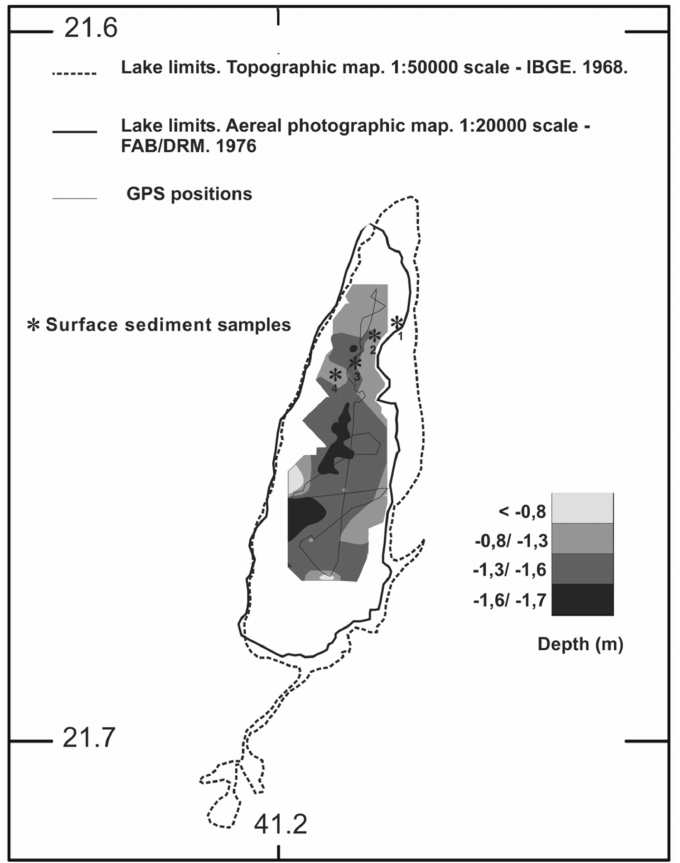
Fig. 3 – Bathymetric map of the Lagoa do Campelo Lake with the localization of the surface sediment